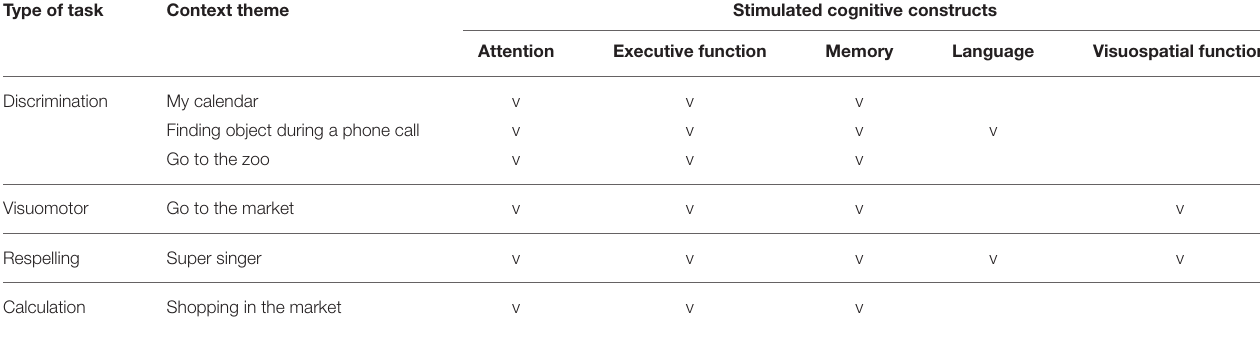
TABLE 6 | Game tasks, contexts and stimulated cognitive